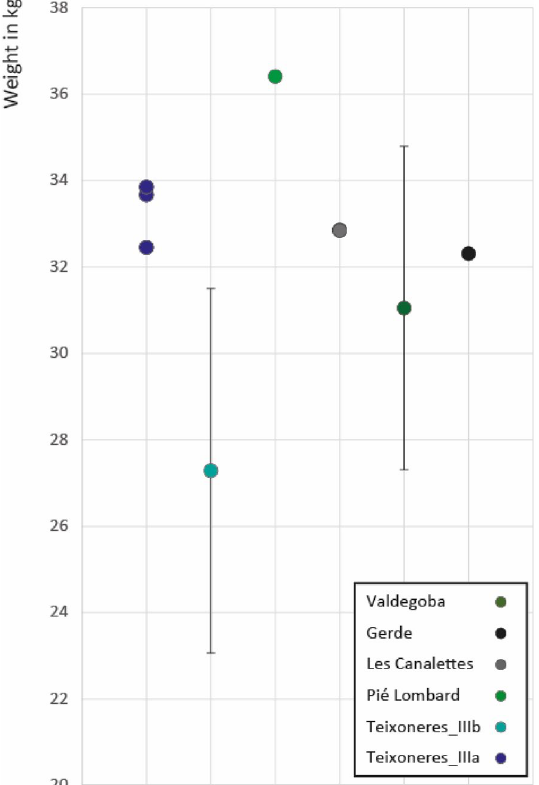
Figure 5. Weight estimation of Capreolus from Teixoneres, Pié Lombard, Cueva de Valdegoba, Level V 115 , Gerde 117 and Abri des Canalettes 113 . Weight estimated through the measurements of M2, m1, m2 and m3 (equations from Janis 72